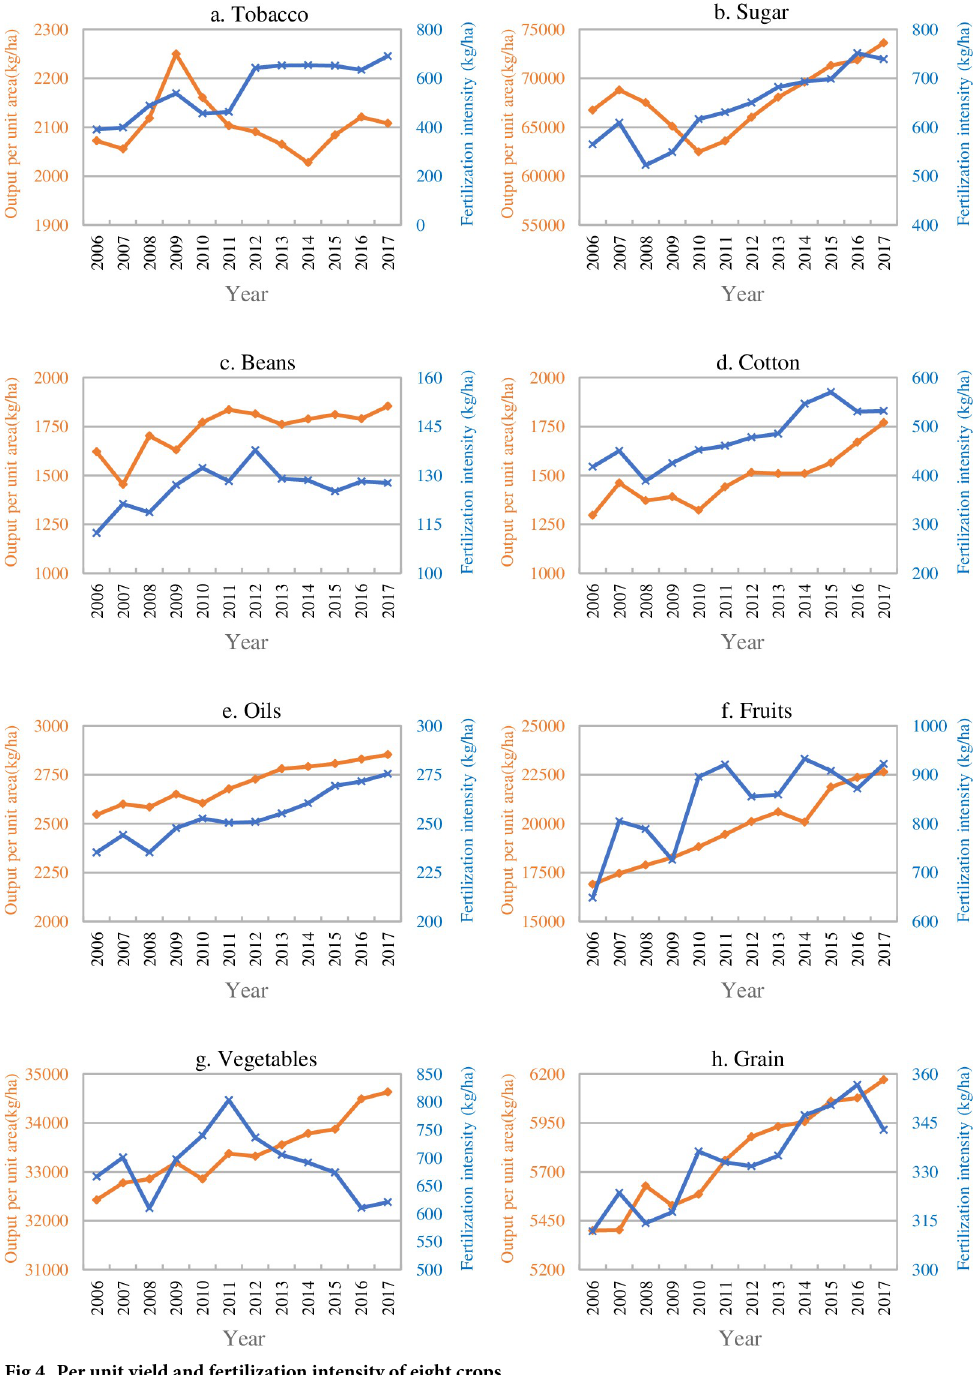
Fig 4. Per unit yield and fertilization intensity of eight